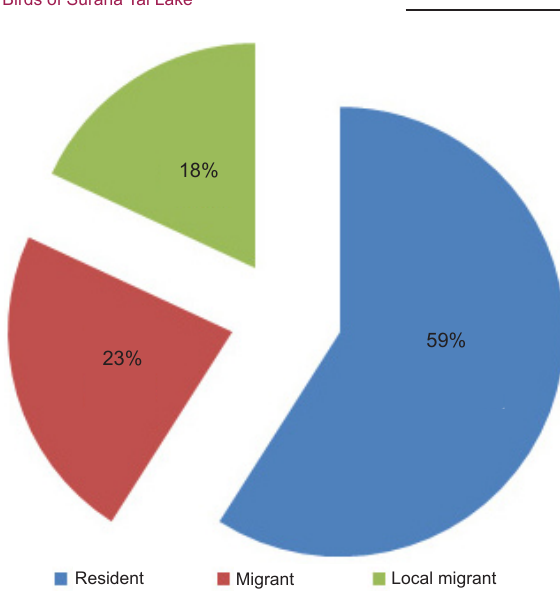
Figure 1. Percentage composition of avifauna of Suraha Tal Lake